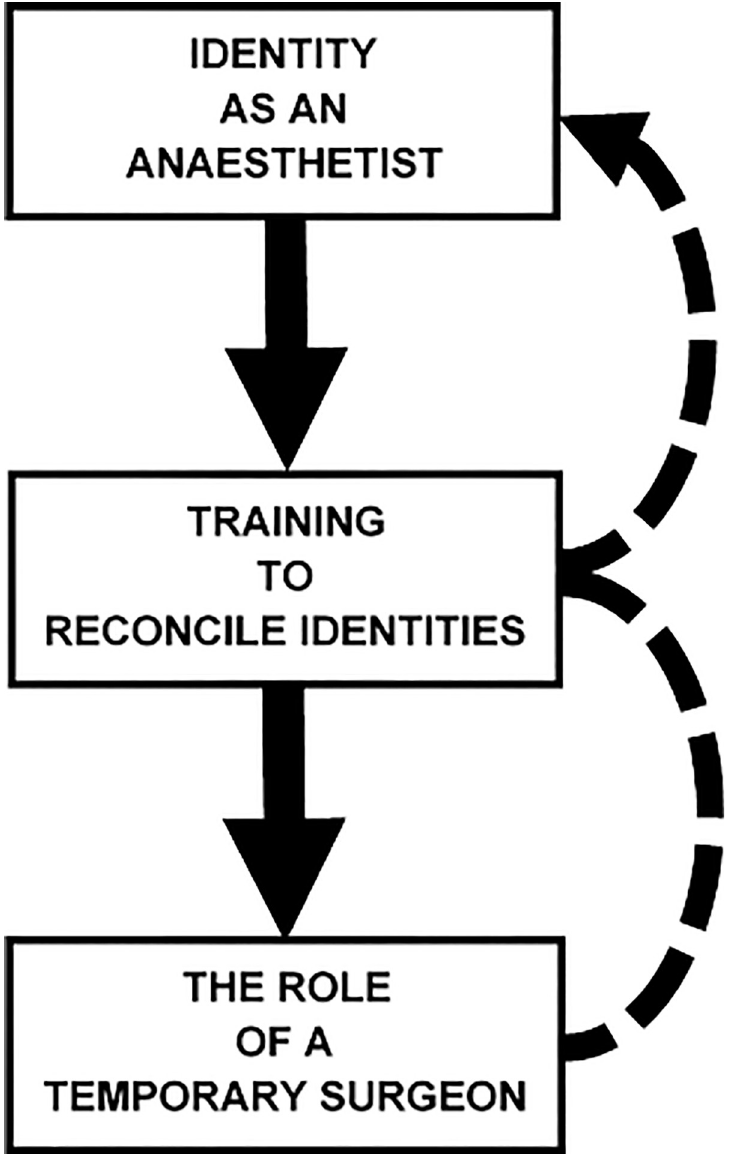
Fig 3. Thematic diagram of